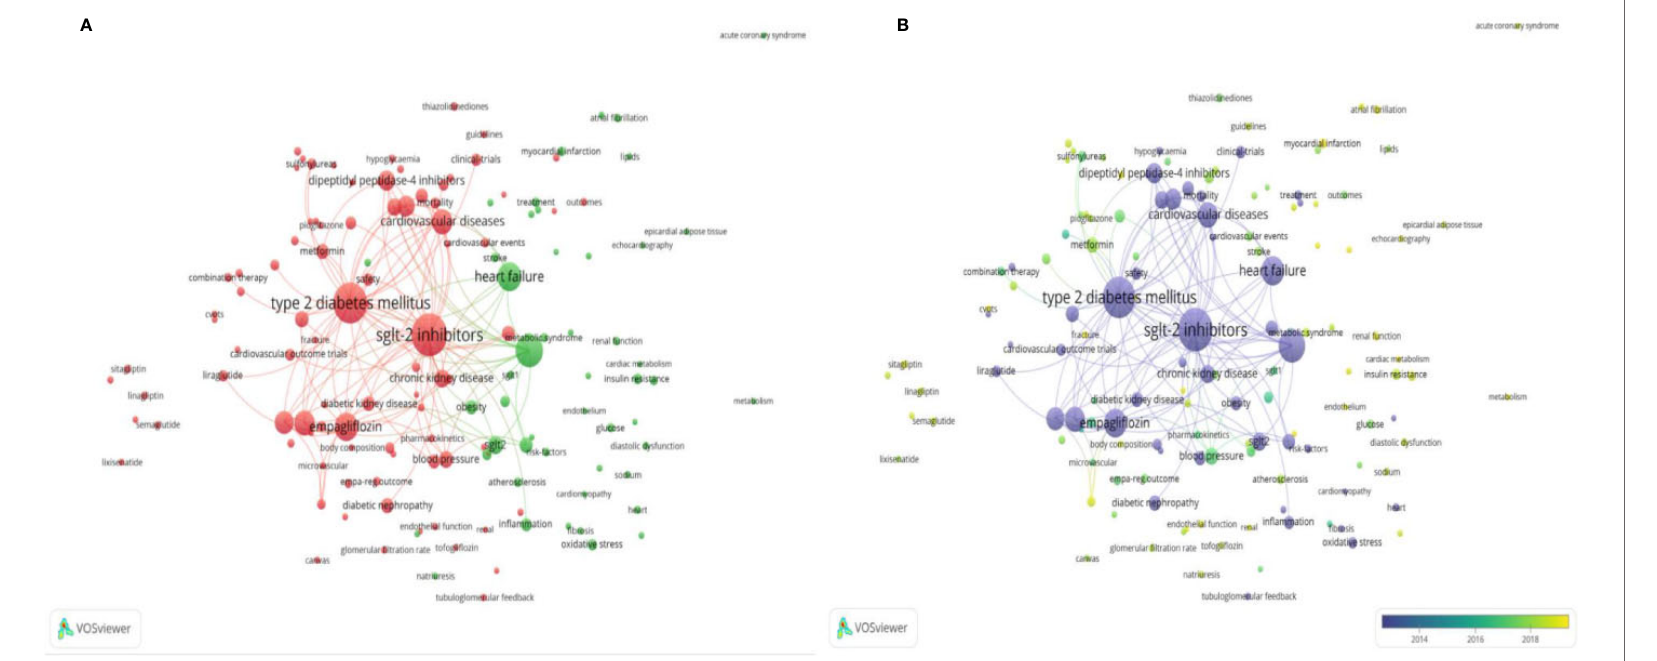
FIGURE 6 | Analysis of author keywords in publications related to SGLT2 inhibitors in cardiovascular research from 2013 to 2020. (A) VOSviewer network visualization map of co-occurring author keywords. Of the 1,893 keywords, 141 had at least fi ve co-occurrences. (B) VOSviewer overlay visualization of co-occurring author keywords by